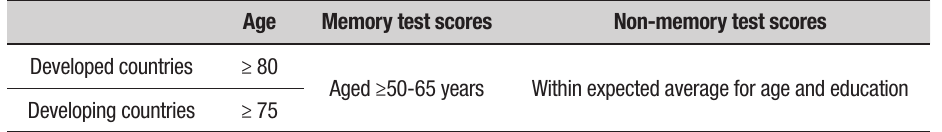
Table 2. Operationalized definition of High-performing older